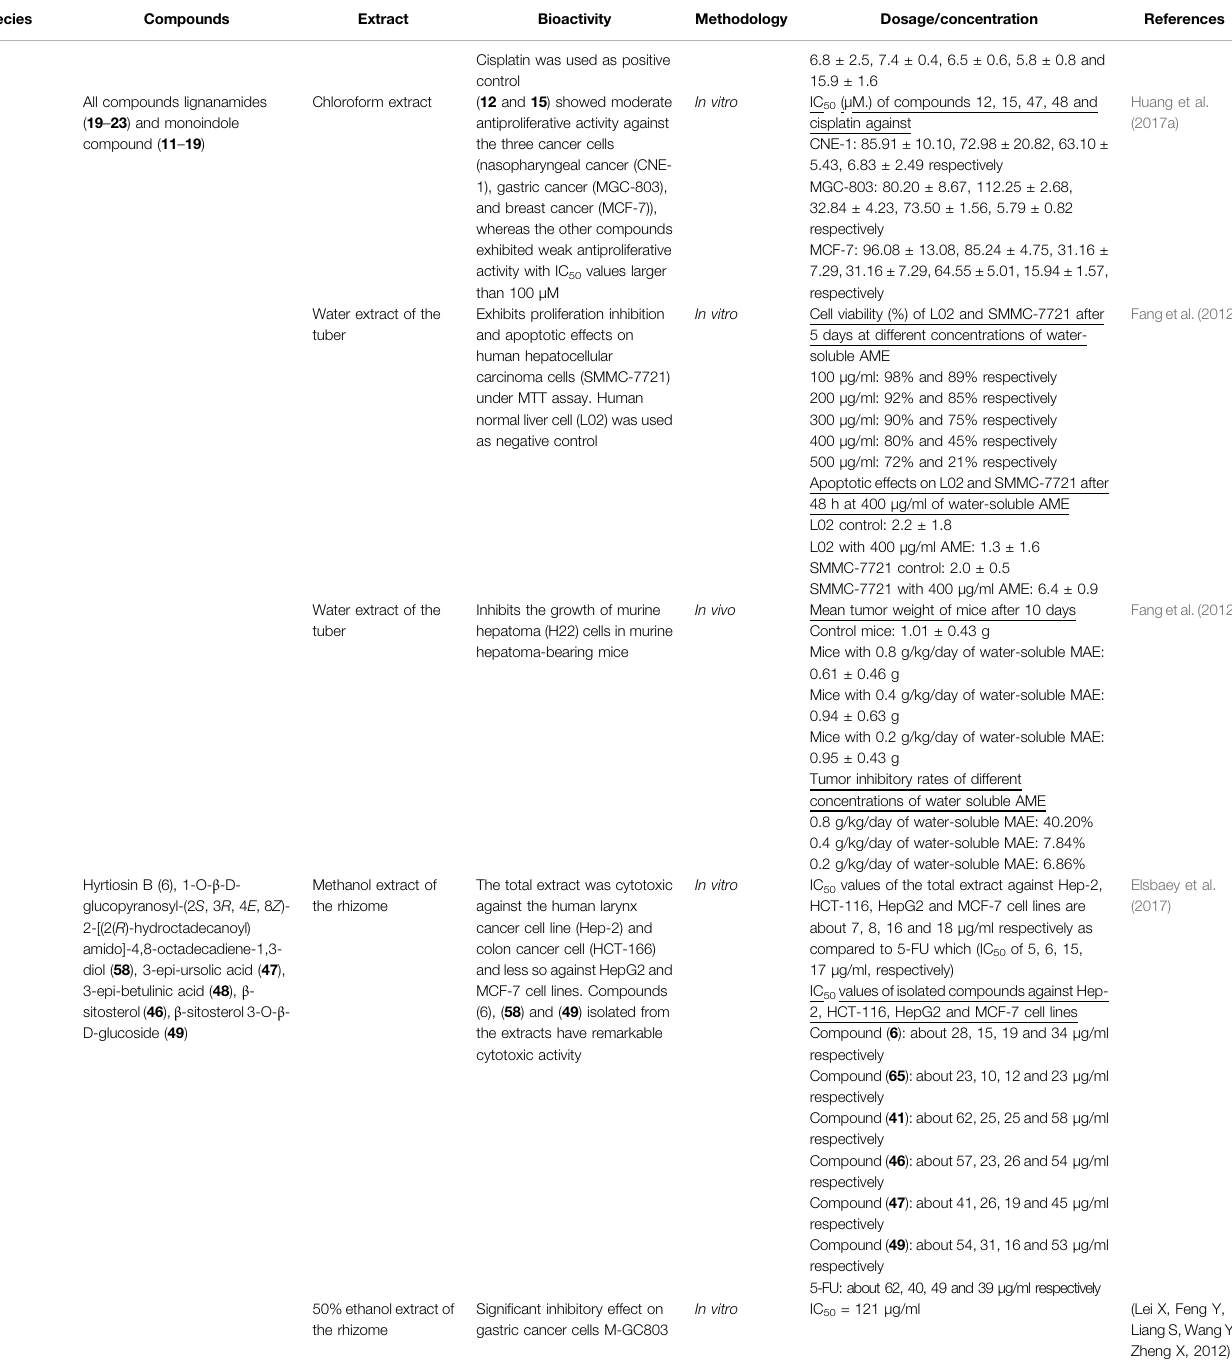
Compound ( 6 ): about 28, 15, 19 and 34 μ g/ml respectively Compound( 65 ):about23,10,12and23 μ g/ml respectively Compound( 41 ):about62,25,25and58 μ g/ml respectively Compound( 46 ):about57,23,26and54 μ g/ml